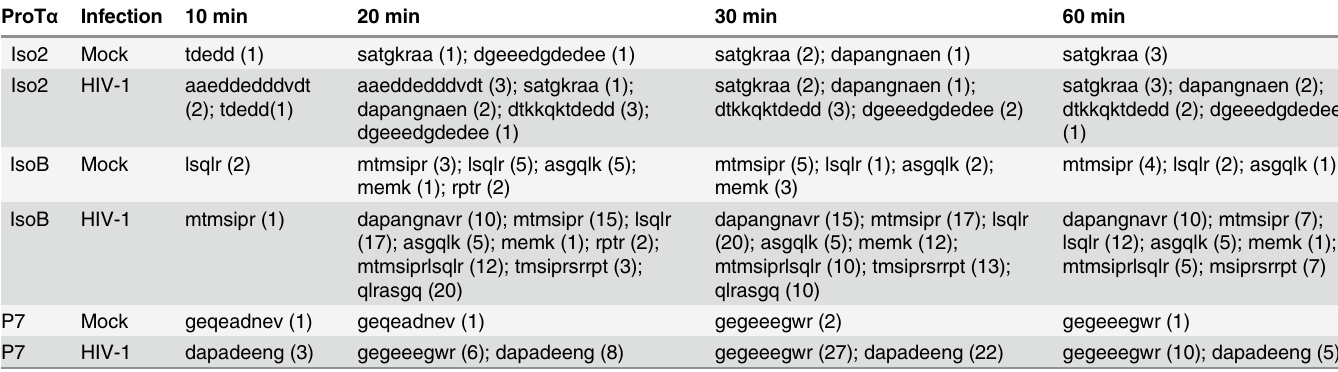
Table 2. Mass spectrometry identification of the amino acid sequences and frequency of peptides (in brackets) released by PBMCs in response to HIV infection. ProT α Infection 10